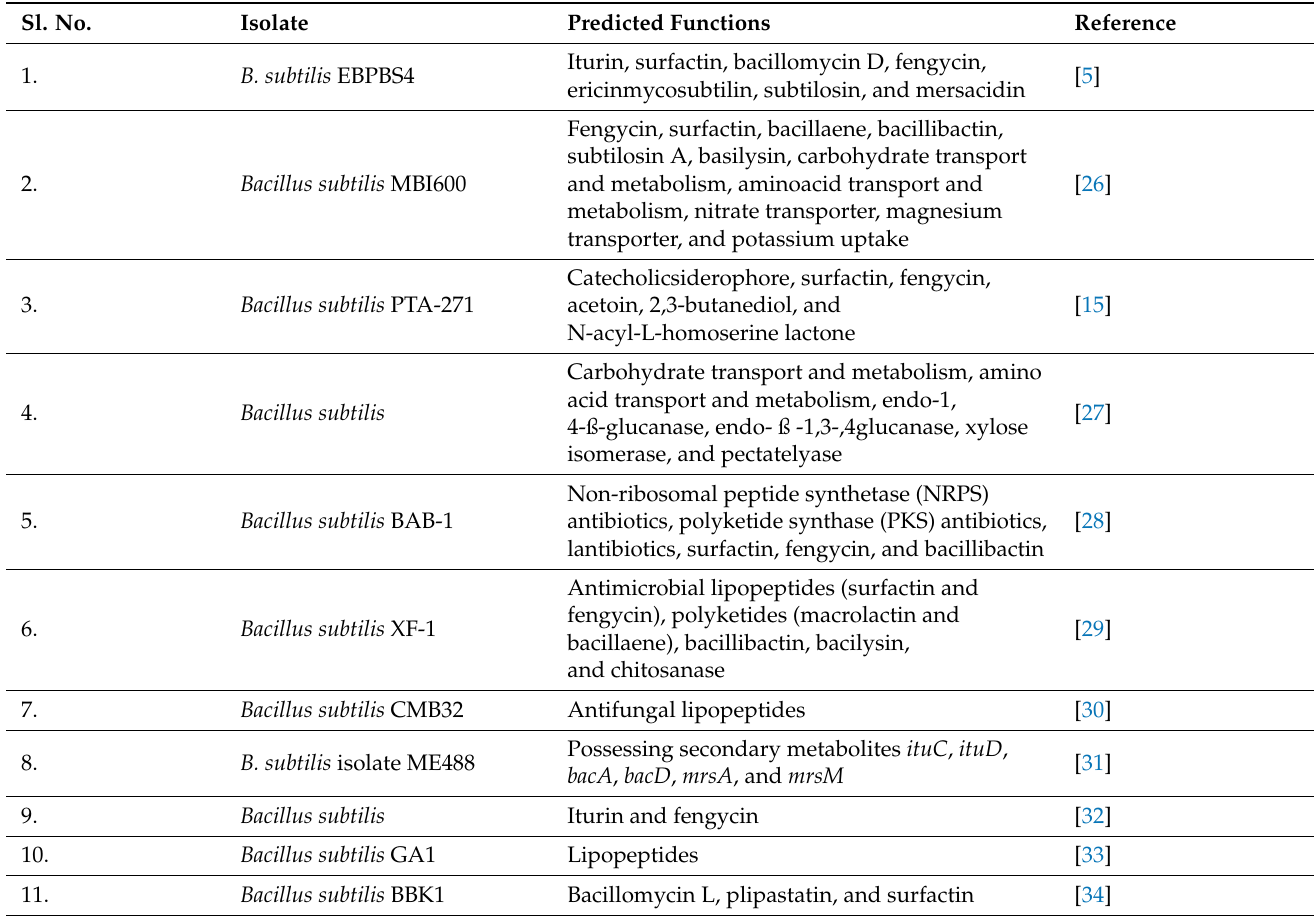
Table 3. Functions of genes in the genome of various Bacillus subtilis